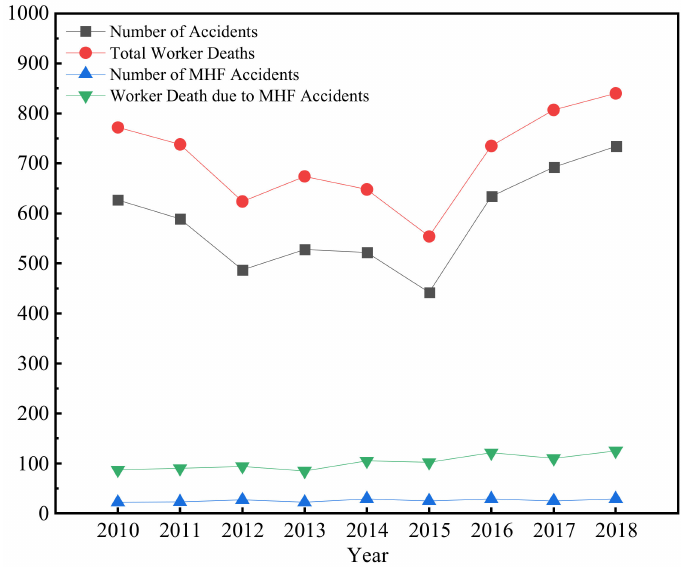
Figure 1. Building and civil construction